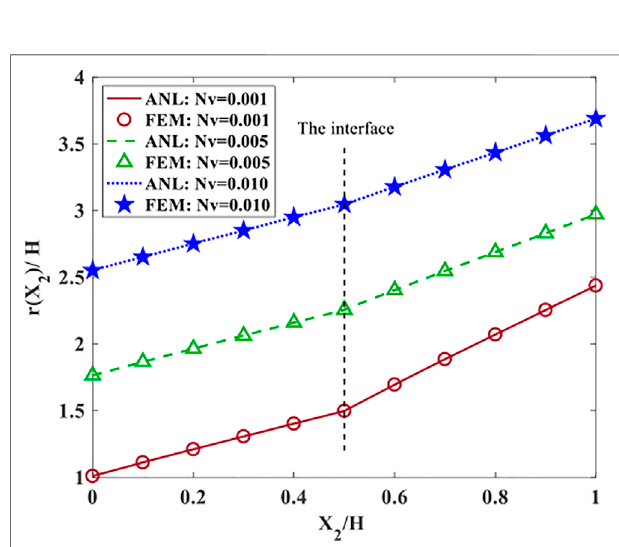
FIGURE 8 | The comparison of normalized current radius in hydrogel bilayer with diverse cross-linked densities at pH = 8.